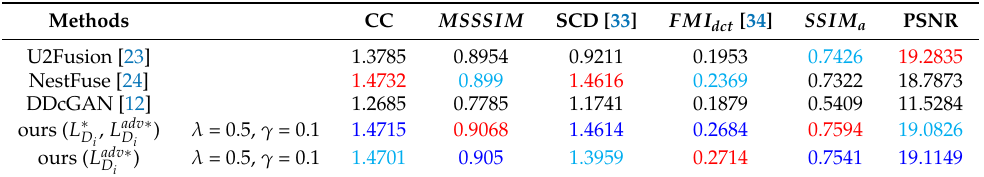
Table 2. The average values of quality metrics for 20 fused images of our private dataset with λ = 0.5 and γ = 0.1 used in the loss function. The best values are indicated in red, the second best values are indicated in blue and the third highest values in cyan.